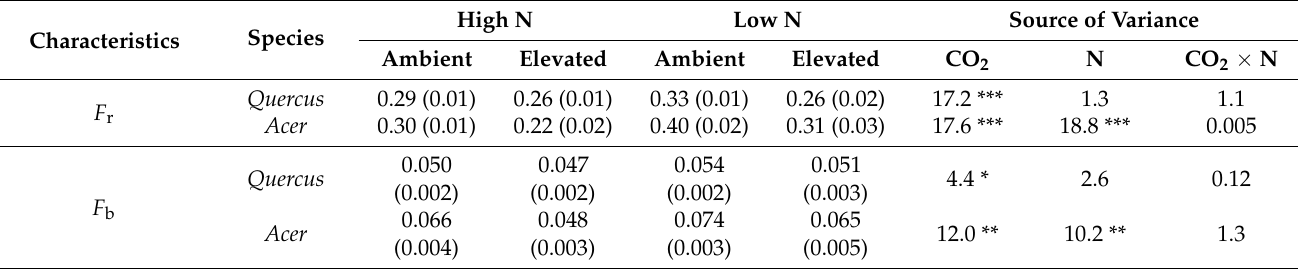
Figure 2. Relationship between area-based leaf N content ( N area ) and maximum carbon fixation rate ( V cmax ) and maximum electron transfer rate ( J max ) of Quercus mongolica (1.5-month-old leaves) ( A , C ) and Acer mono (1-month-old leaves) ( B , D ). Open symbols: ambient CO 2 ; closed symbols: elevated CO 2 ; circles: high N; triangles: low N. Results of the generalized linear mixed model ( χ 2 -value and p -value) are indicated besides the panel. The two N treatments (high N and low N) were analyzed together in this instance. Table 2. The allocation coefficient of leaf N to carboxylase reactions ( F r : g N in Rubisco (g total leaf N) − 1 ) and to bioenergetic pools ( F b : g N in cytochrome f, ferredoxin NADP reductase, and coupling factor (g total leaf N) − 1 ) in Quercus mongolica ( Quercus ; 1.5-month-old leaves) and Acer mono ( Acer ; 1-month-old leaves). Mean values (standard error) for each treatment are shown ( n = 5–9). Results of ANOVA ( F -value) for CO 2 treatments (ambient: ambient CO 2 ; elevated: elevated CO 2 ) and N treatments (high N, low N) are shown. * p < 0.05; ** p < 0.01; *** p <